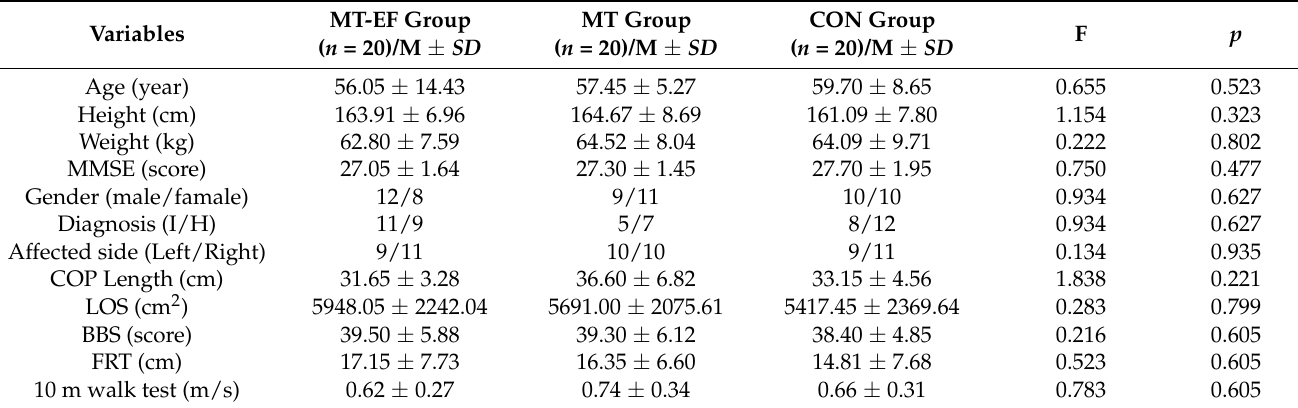
Table 1. The general characteristics of the subjects ( n = 60).